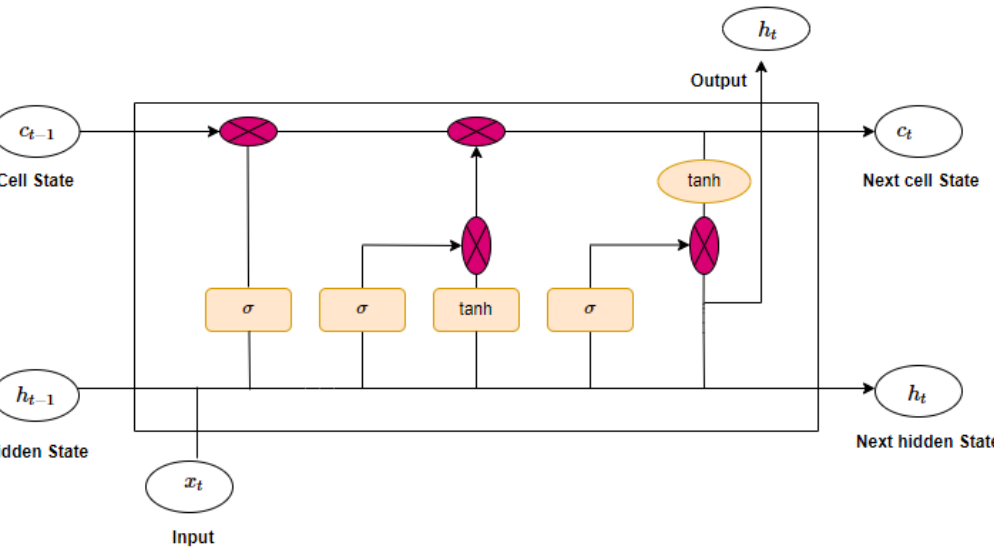
Figure 8. The structure of a long short-term memory (LSTM)